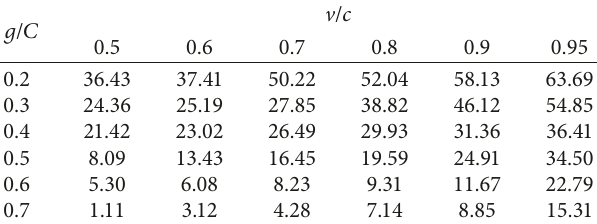
Table 7: Actual delay (simulated) for different λ , x